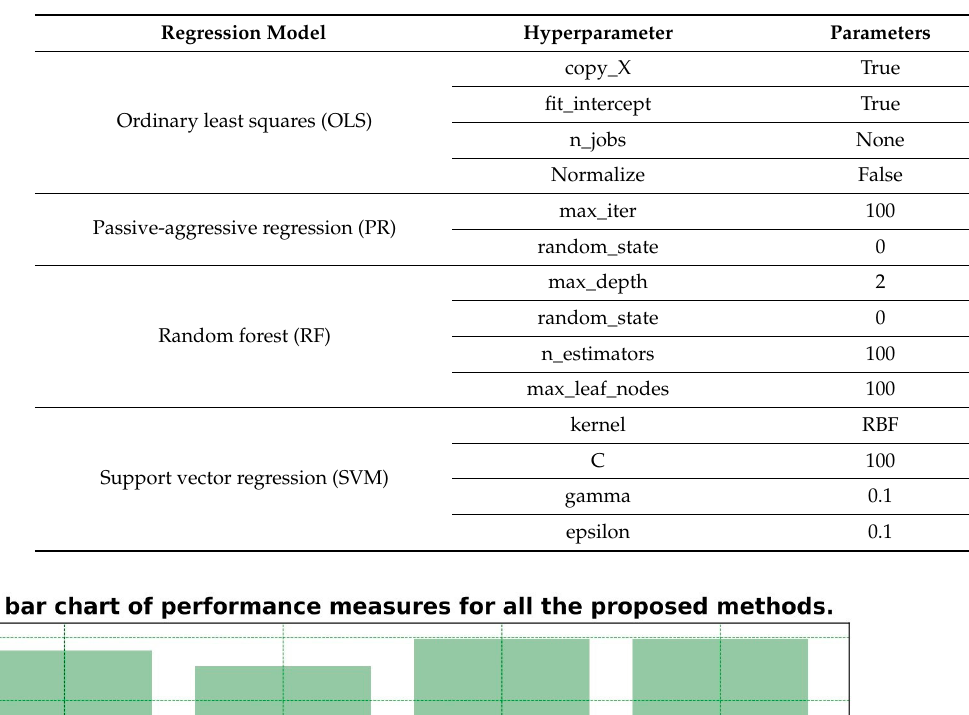
Table 3. Hyperparameters of the proposed ML models.